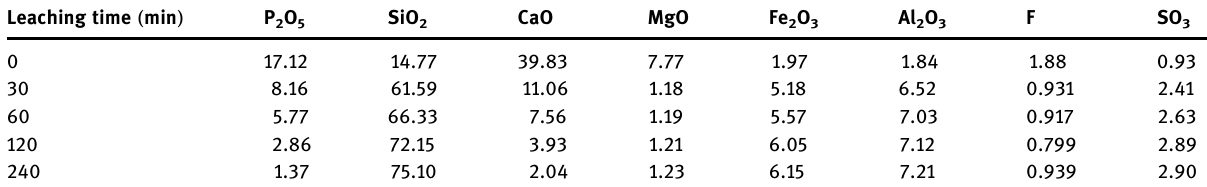
Leaching time ( min )